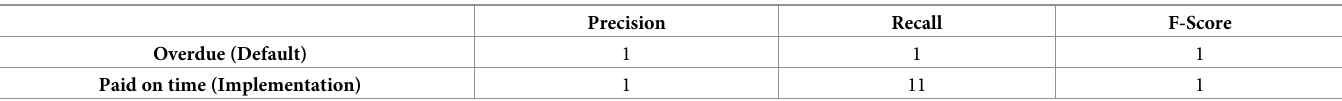
Table 5. Comparison of